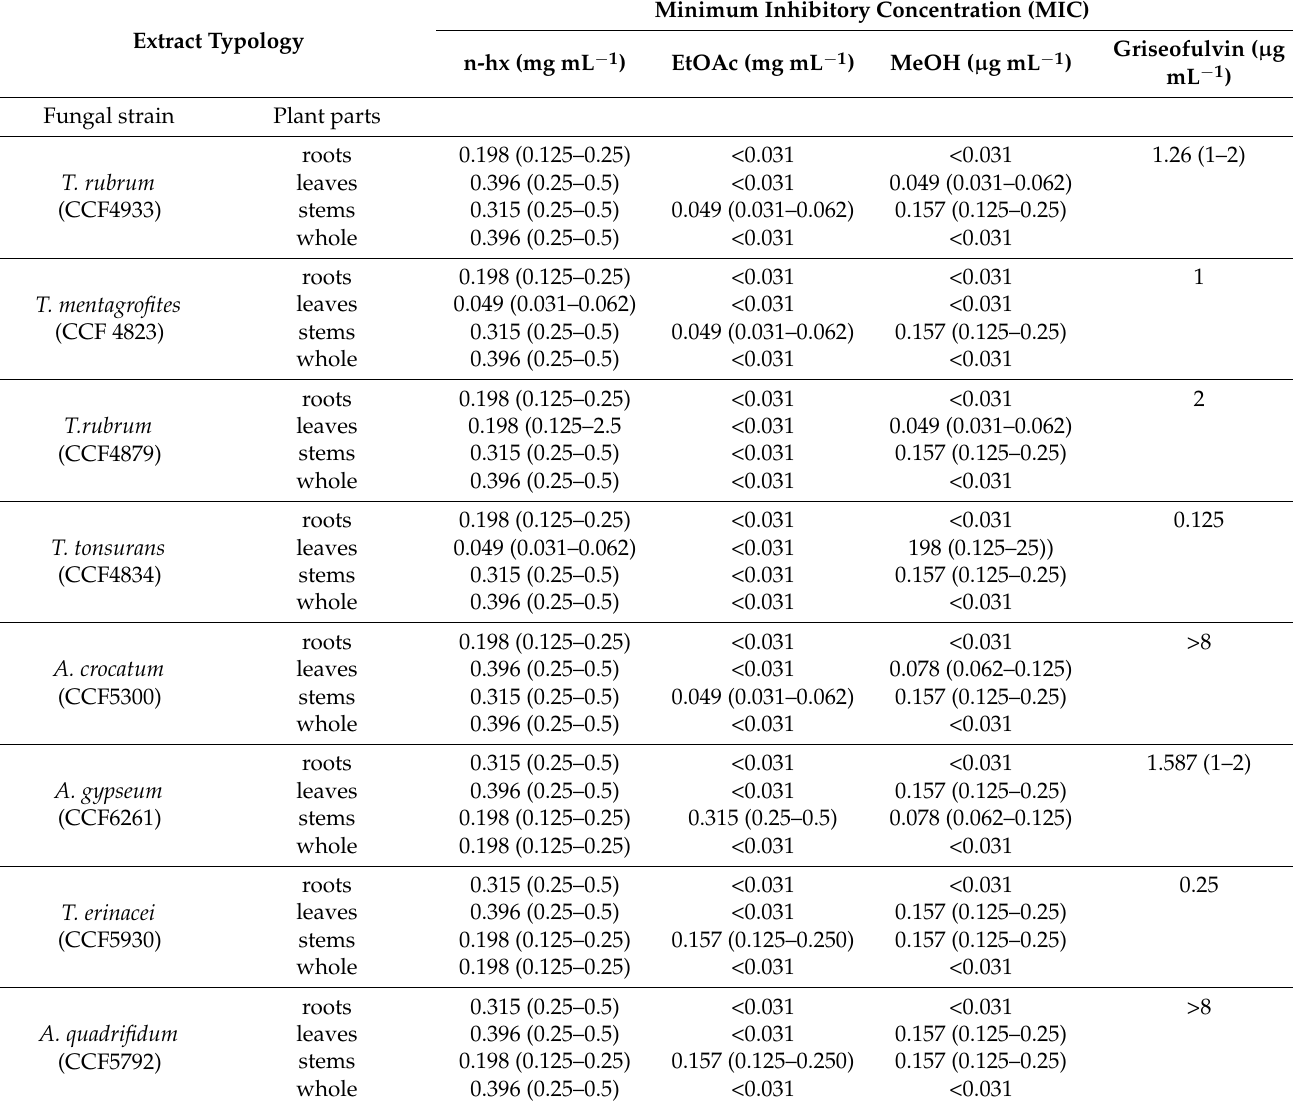
Table 5. Minimal inhibitory concentrations (MICs) of B. pilosa n-hexane, ethyl acetate, methanol extracts and griseofulvin against clinical